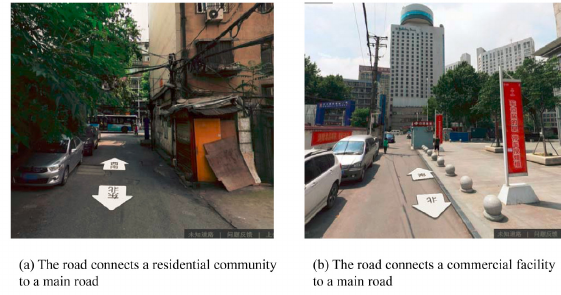
Figure 8. Omission roads in OSM marked as public roads but not yet